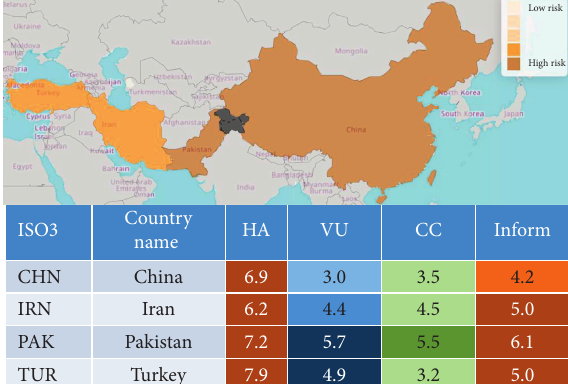
Figure 9: Inform global risk index of four countries in 2019. Source: https://drmkc.jrc.ec.europa.eu/inform-index/INFORM- Risk (European